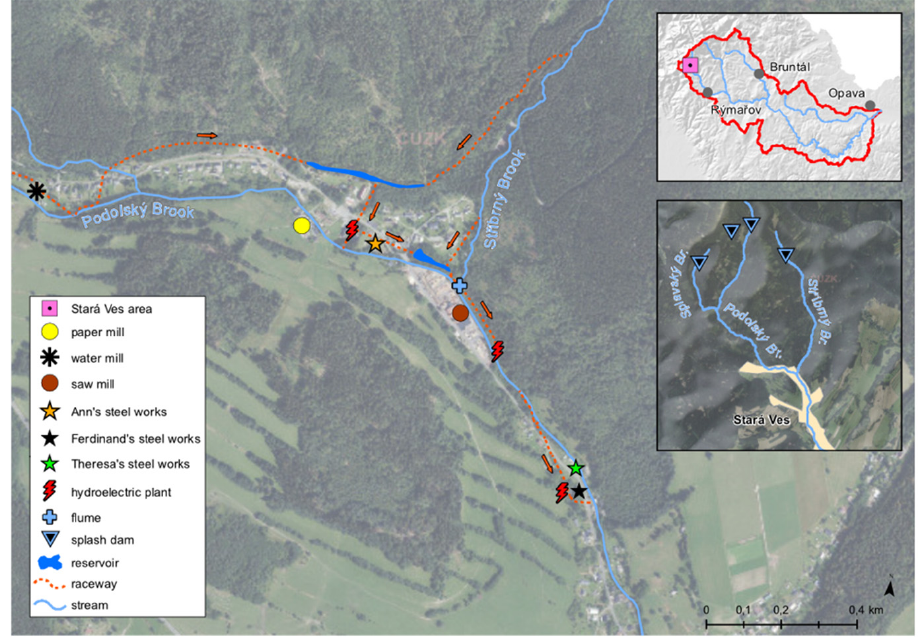
Figure 9. A map of the Stará Ves water management scheme.